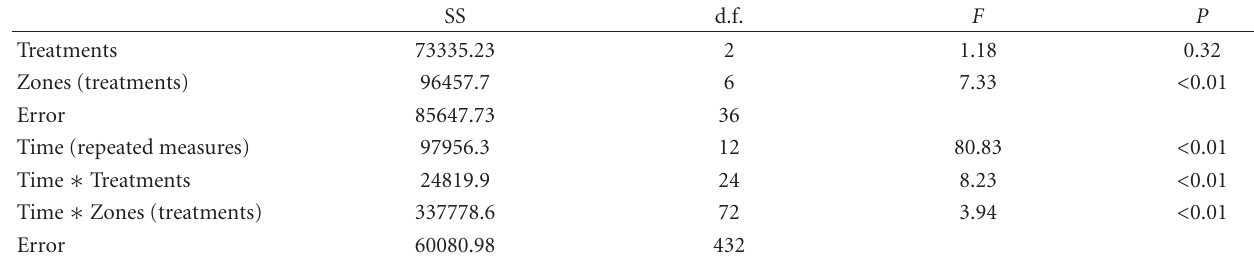
Table 2: Results of the nested repeated measures ANOVA test the e ff ect of treatments (burning, cutting, and ploughing) in the mean cover of dominant species, nesting zones (A, B, and C) into treatments.